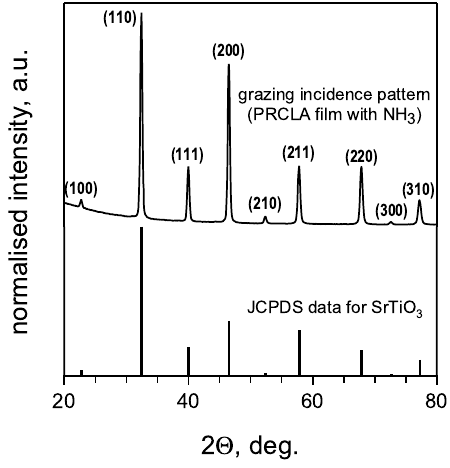
:N. All observed reflexes are in 3 , confirming the perovskite-type phase purity. 3